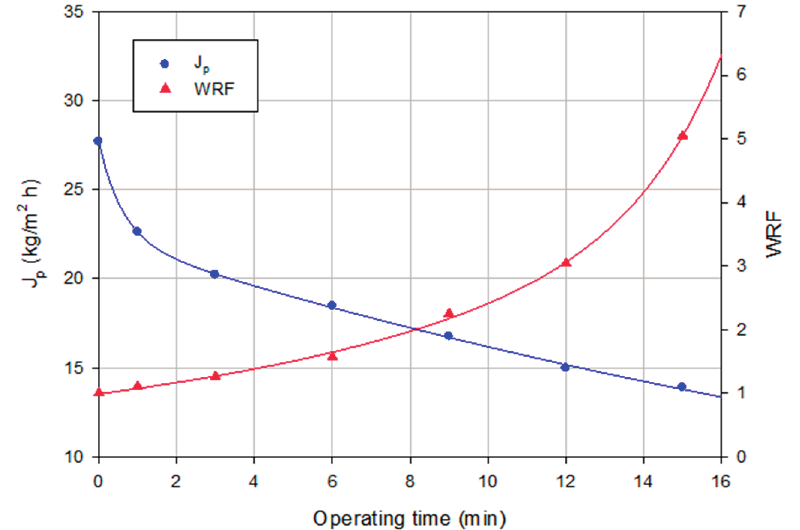
Figure 11. Nanofiltration of NP030 permeate stream with the Desal DK membrane. Time course of permeate flux and WRF (batch concentration configuration, 10 bar, 25